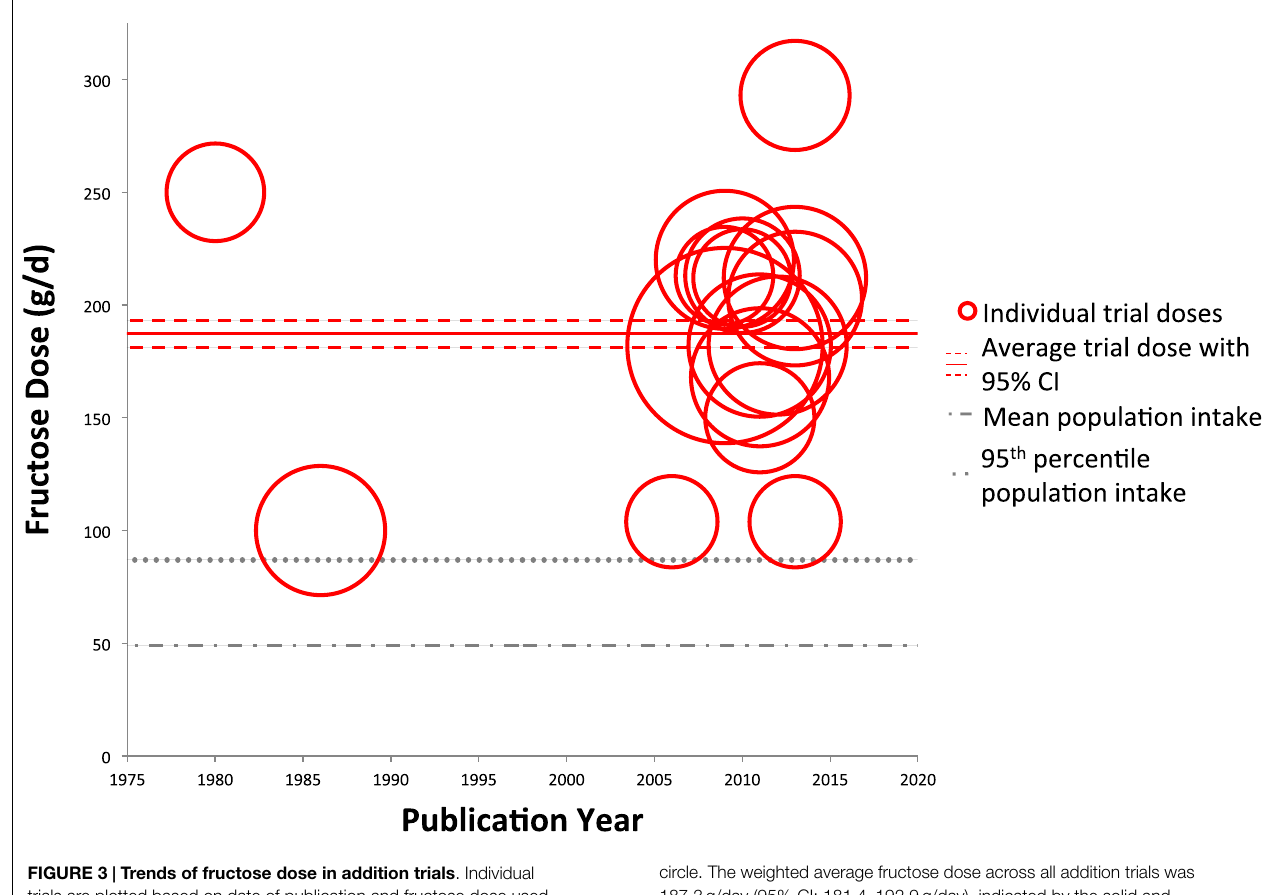
FIGURE 3 | Trends of fructose dose in addition trials . Individual trials are plotted based on date of publication and fructose dose used. Sample size of each trial is represented by the size of its respective